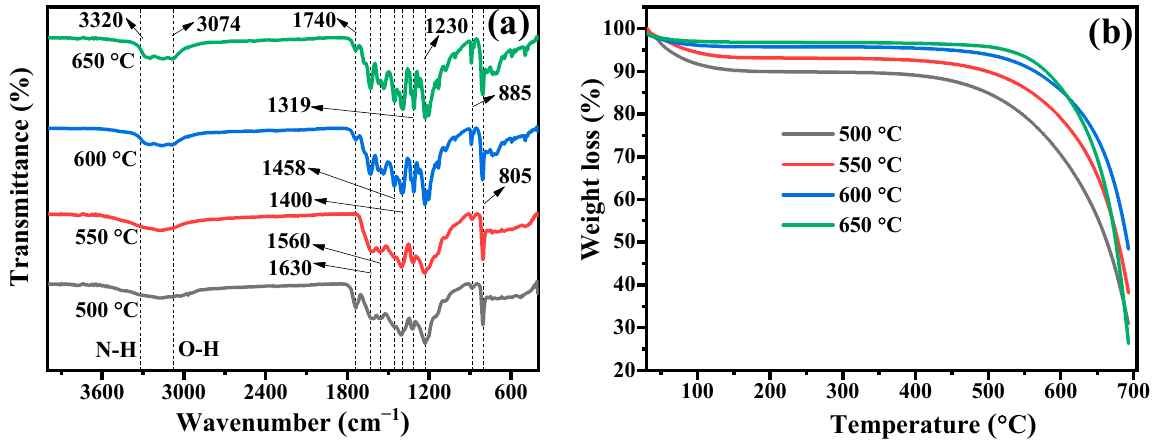
Figure 4. ( a ) FTIR spectra and ( b ) TGA curves of g-C 3 N 4 photocatalysts prepared at different calcination temperatures .